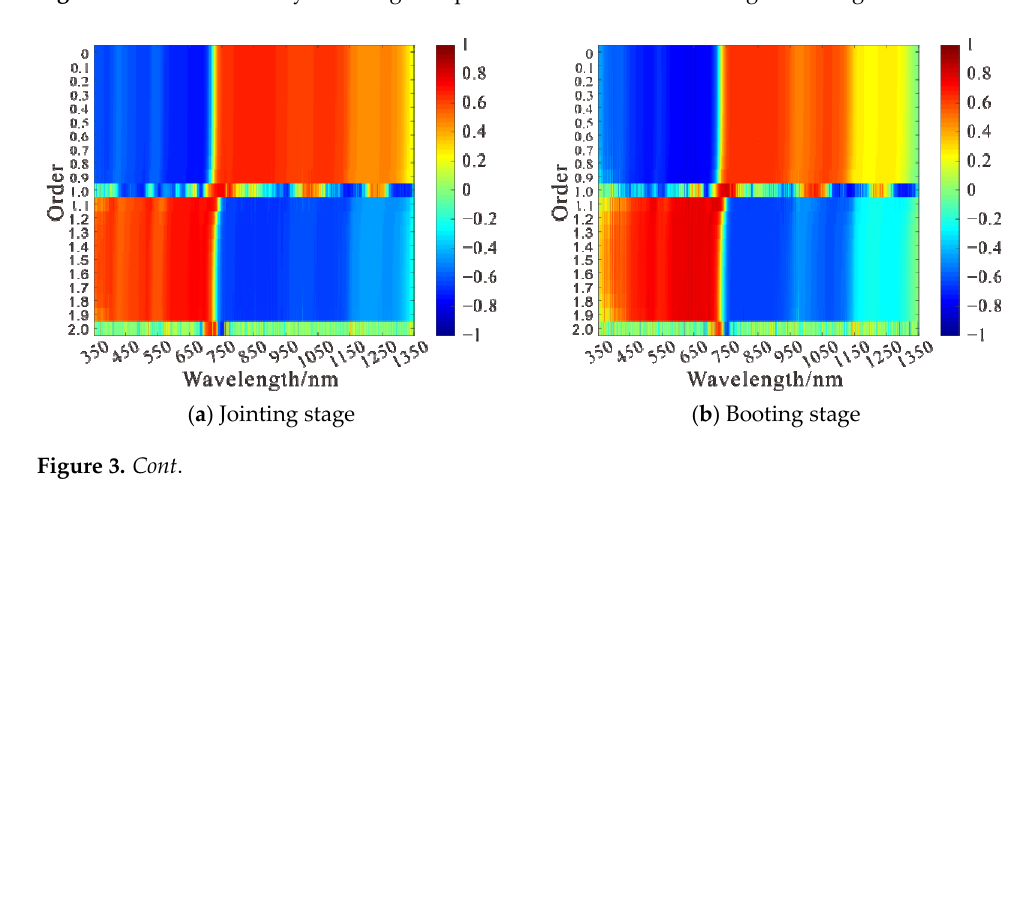
Figure 2. Correlation analysis of original spectrum and LAI at different growth stages.